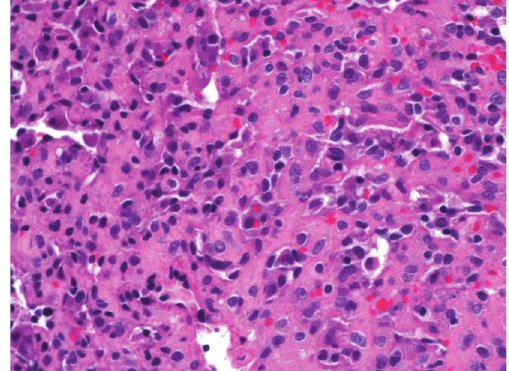
Figure 3: High-power view shows epithelioid tumor cells with mild to moderate nuclear pleomorphism, moderate amount of eosinophilic cytoplasm, and lining slit-like vascular spaces. Occa- sional tumor cells show intracytoplasmic lumen and red blood cells. No mitoses or necrosis was identified in the entire tumor (hematox- ylin and eosin, high power).